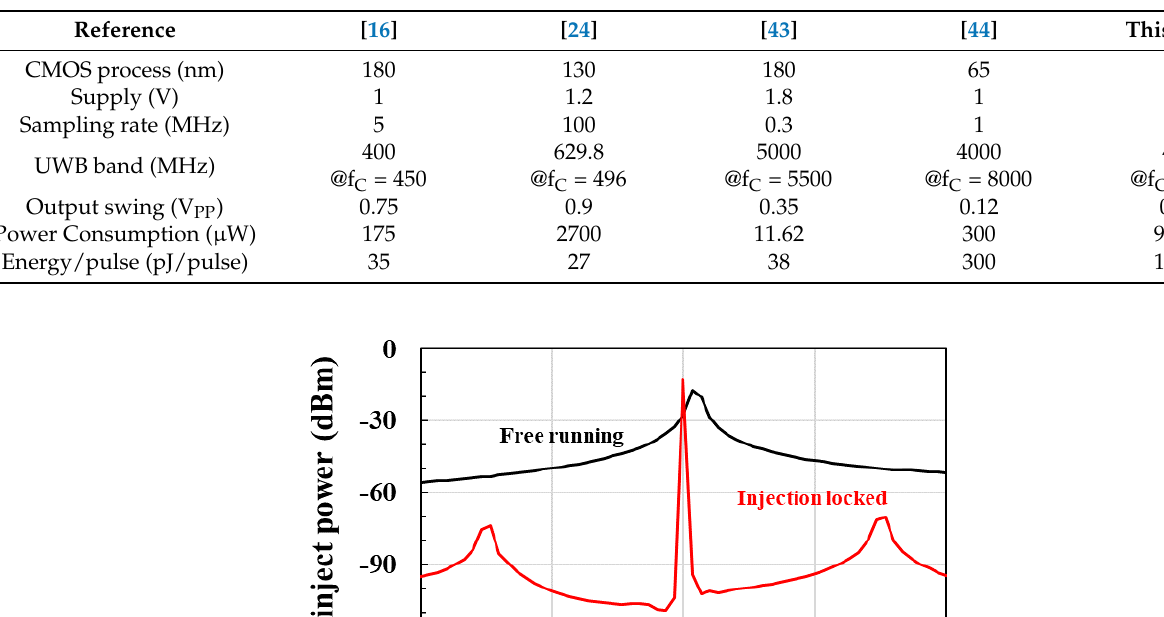
Table 1. Performance summary and comparison.